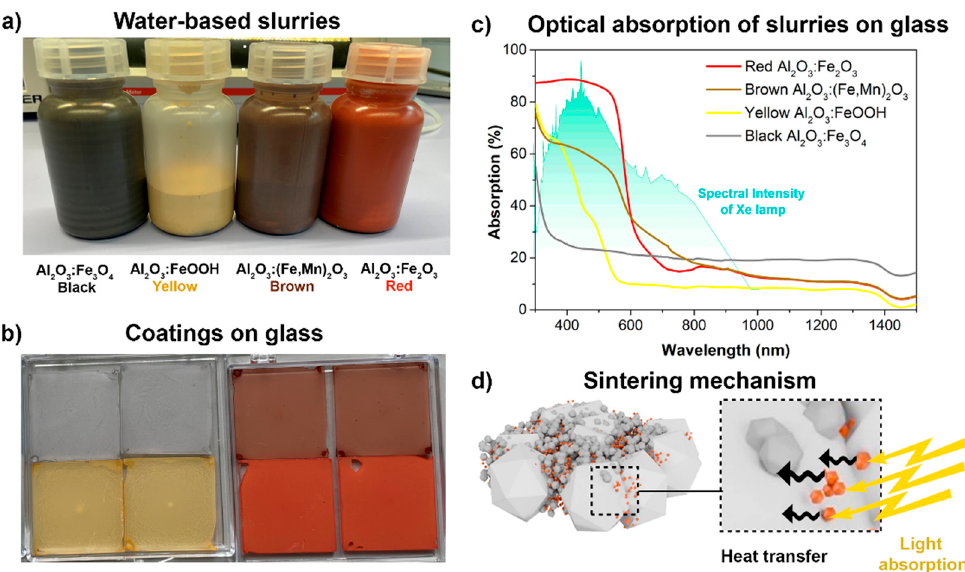
Figure 2. Characterization of slurries and precursor coatings on glass: ( a ) image of the water-based slurries with four different colors, with red α -Fe 2 O 3 , black Fe 3 O 4 , brown (Fe, Mn) 2 O 3 , and yellow α -FeOOH pigments; ( b ) corresponding images of the slurries with various color pigments spin-coated on glass; ( c ) optical absorption spectra of as-coated precursor films on glass superimposed with the FLA lamp spectra; ( d ) schematics of the ceramic sintering mechanism showing light absorption by the colored iron oxide pigments, followed by heat transfer to the matrix e alumina particles.